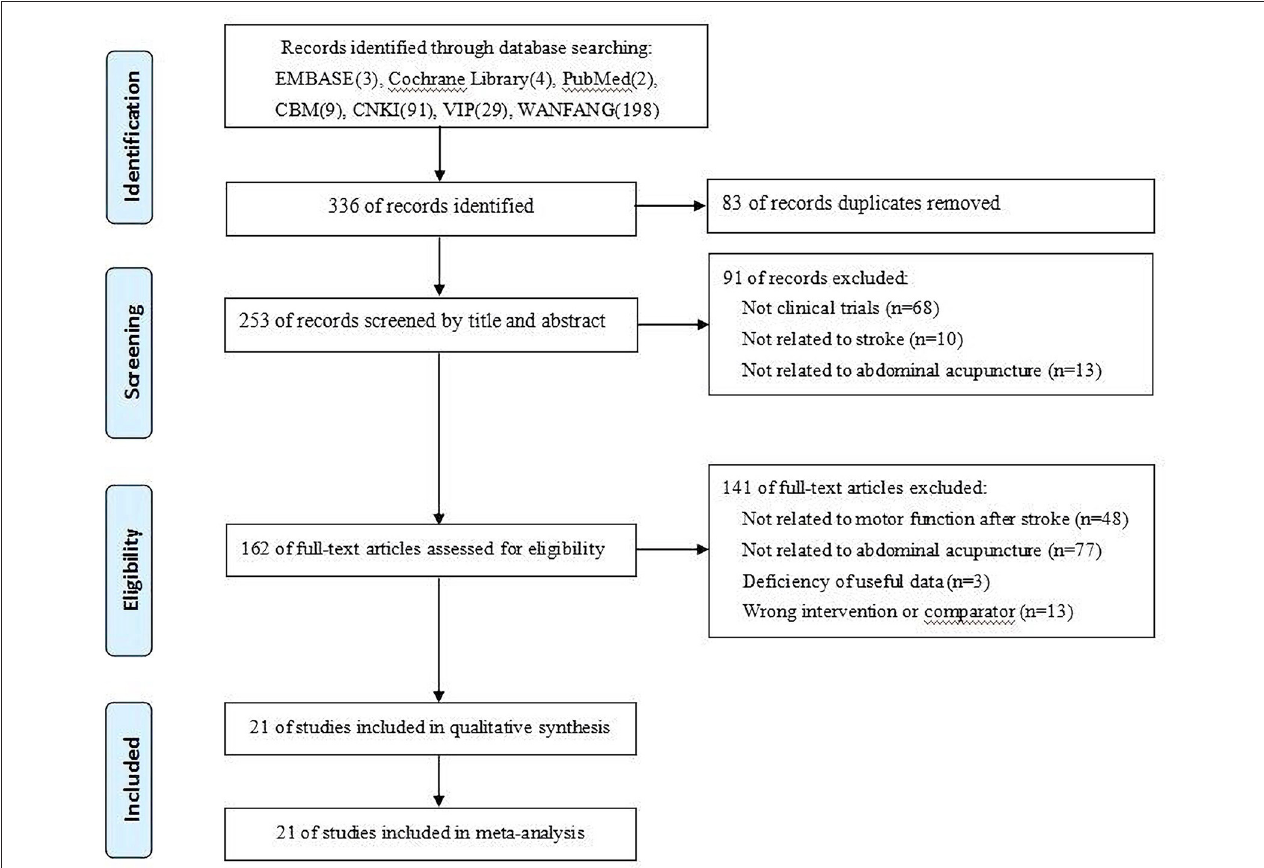
FIGURE 1 | Study flow